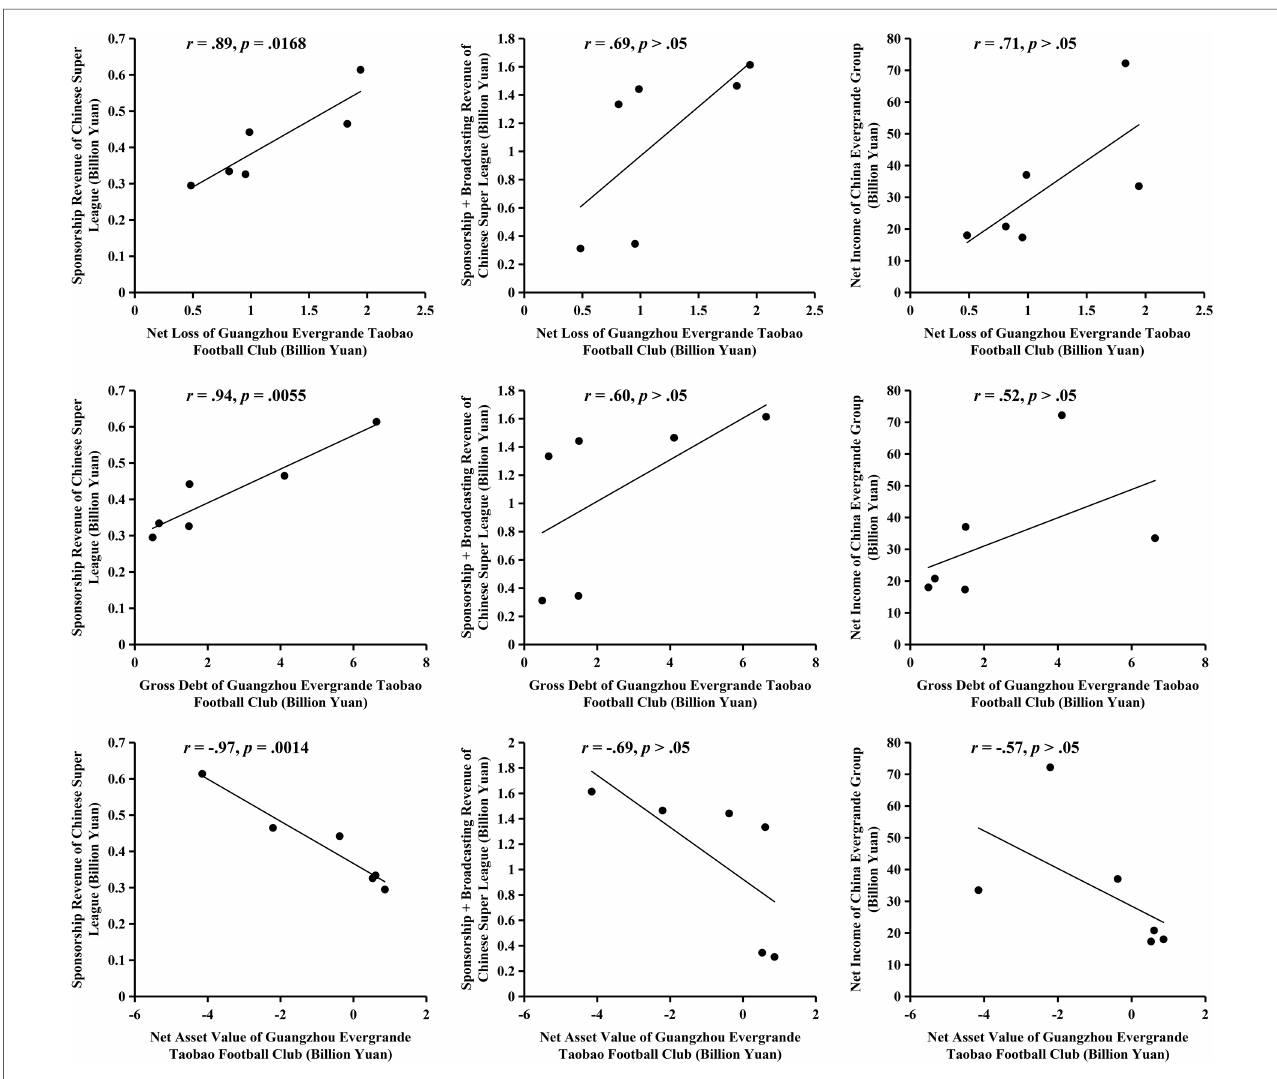
FIGURE 1 Association between evergrande FC ’ s club debt and the pro fi tability of the Chinese super league and evergrande group from 2014 to